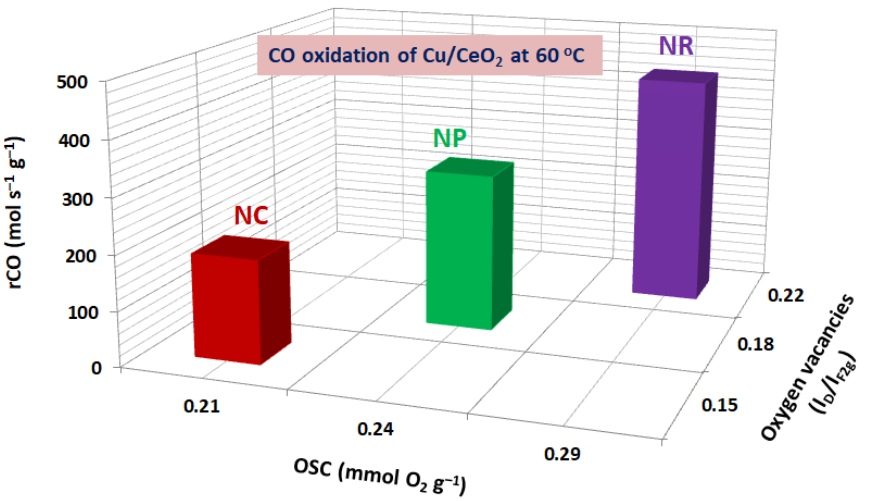
Figure 10. Relationship between the CO oxidation performance (r CO , nmol g ‒1 s ‒1 ) of Cu/CeO 2 samples and the oxygen storage capacity (OSC, mmol O 2 g ‒1 ) as well as the abundance in oxygen vacancies (in terms of I D /I F2g ratio) of ceria nanorods (NR), nanopolyhedra (NP) and nanocubes (NC). Adapted from Ref. [99]. Copyright© 2021, MDPI.